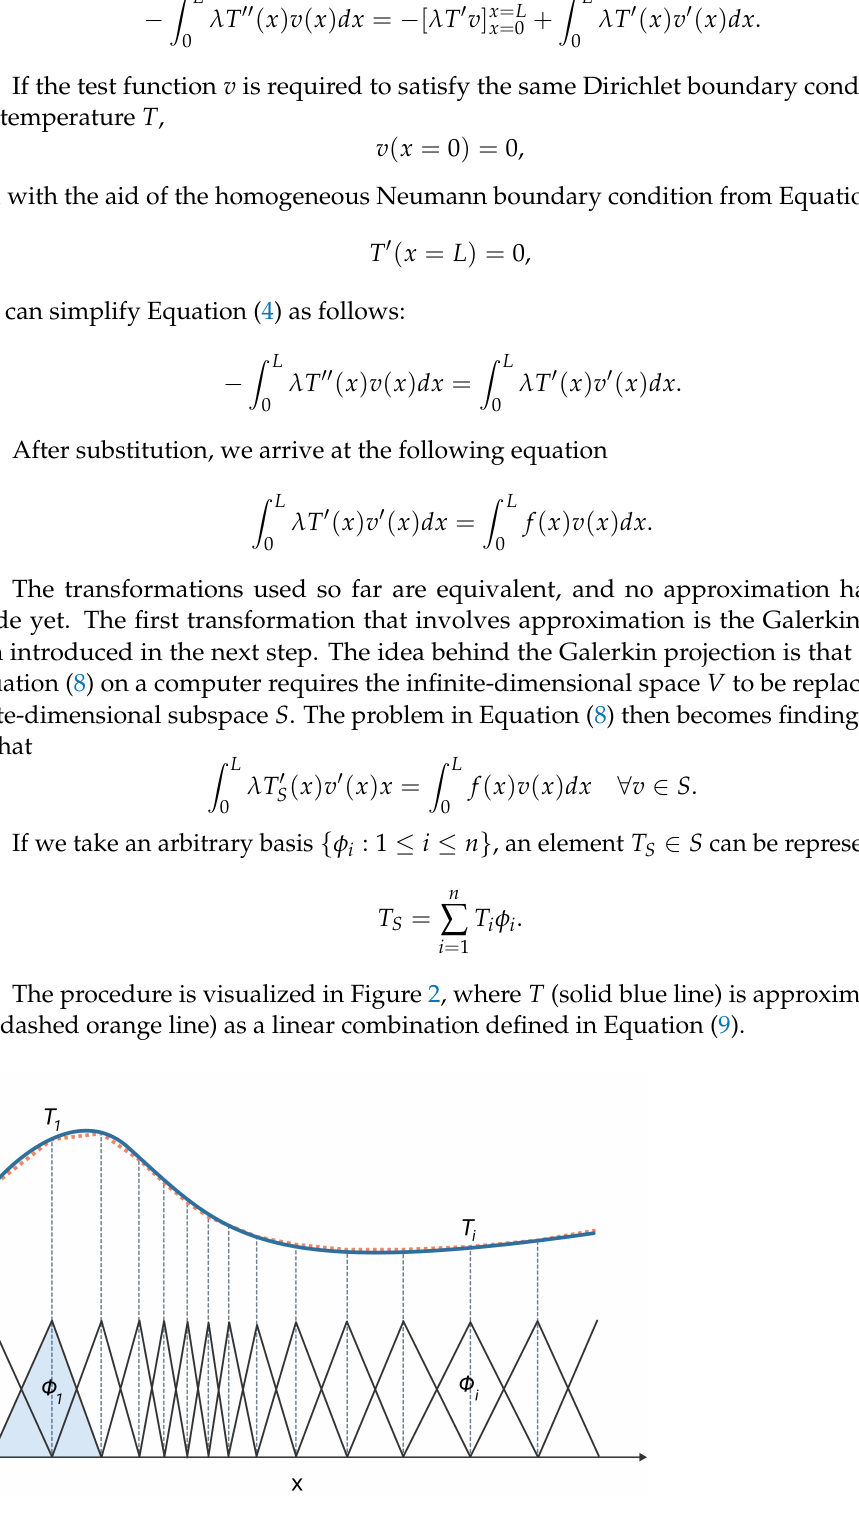
Figure 2. Visualization of T (solid blue line) being approximated by T S (dashed orange line) as a linear combination of linear basis functions φ i (solid black lines). A simple choice of basis functions would be the space of piecewise-linear functions on [ 0,1 ] . Any piecewise-linear function can be uniquely expressed as a sum of scaled